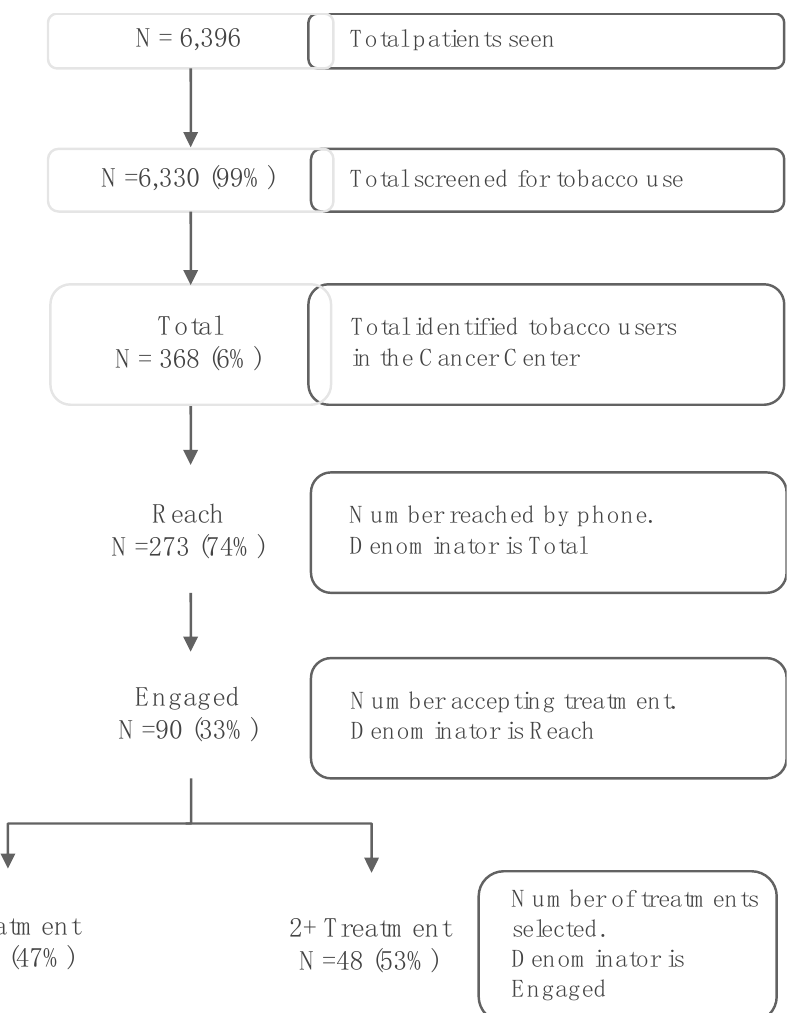
Figure 1. Outreach and Engagement for Tobacco Treatment Services in the QI Pilot.